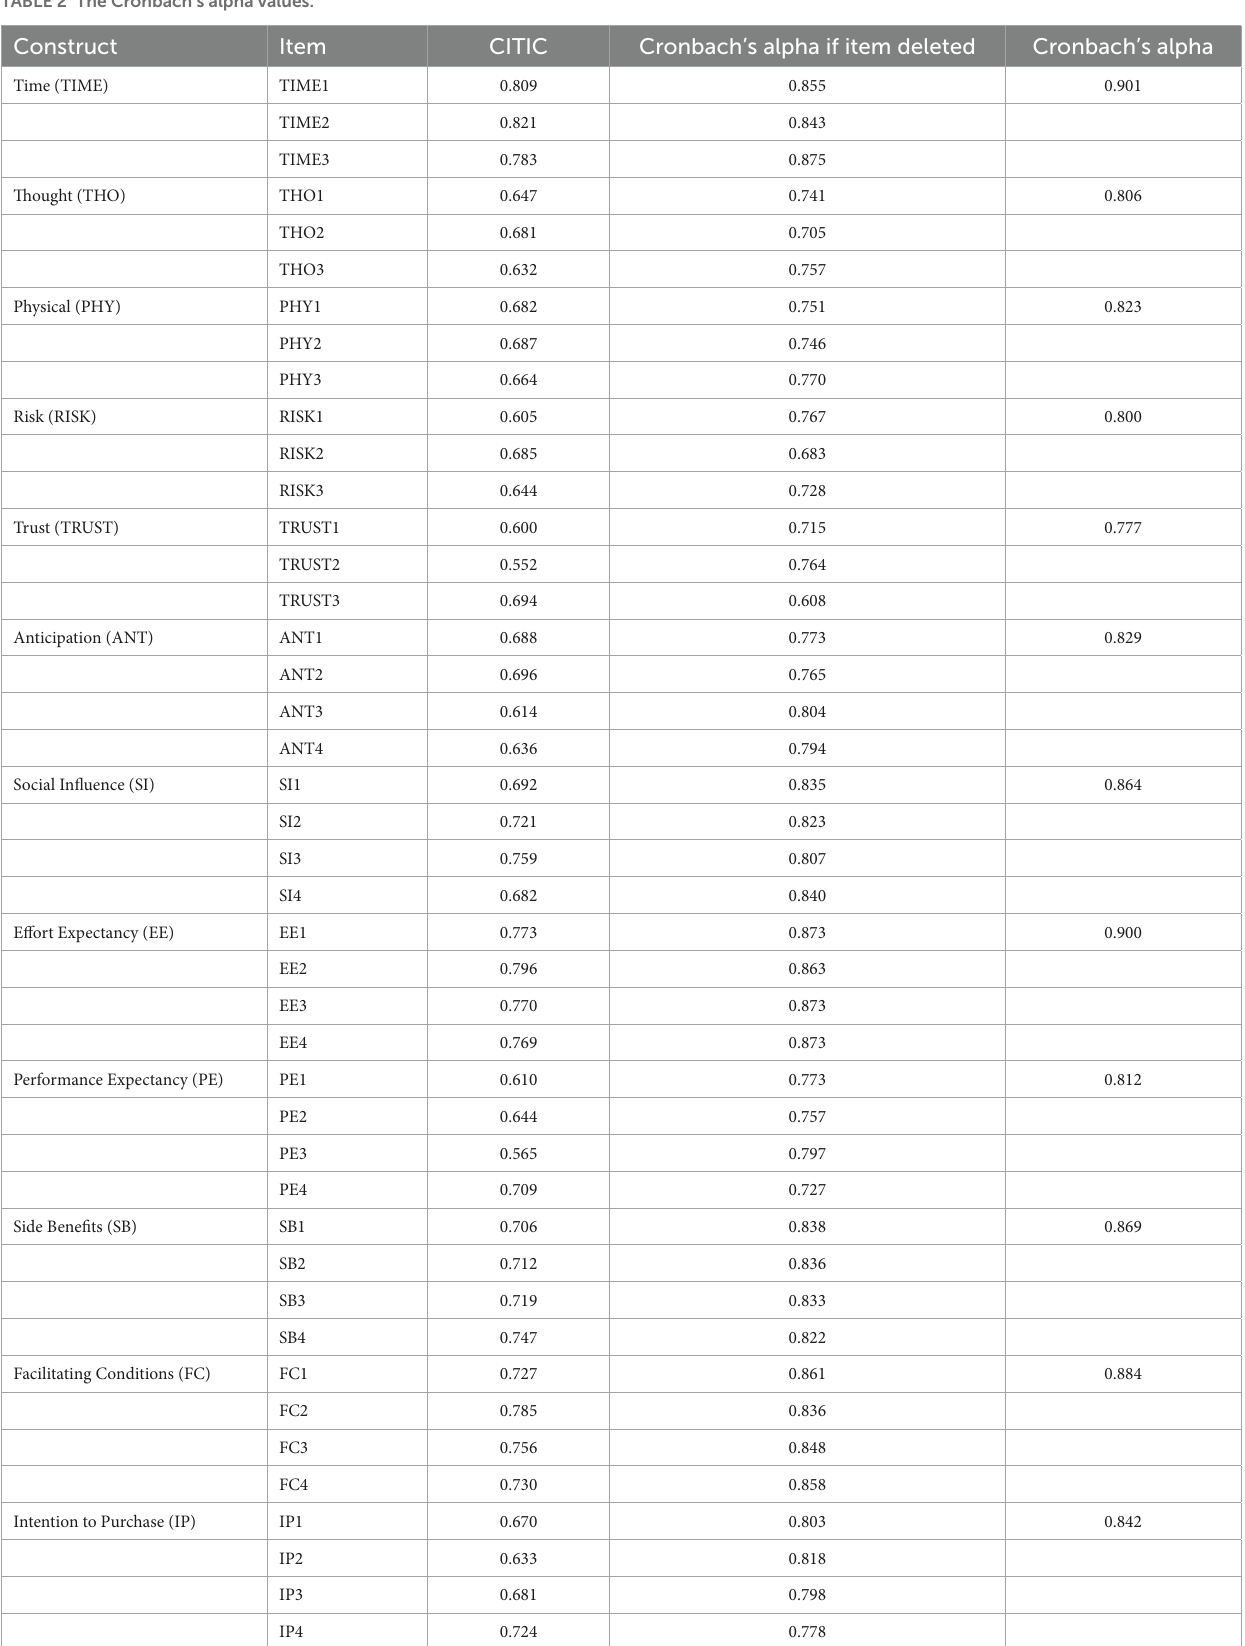
TABLE 2 The Cronbach’s alpha